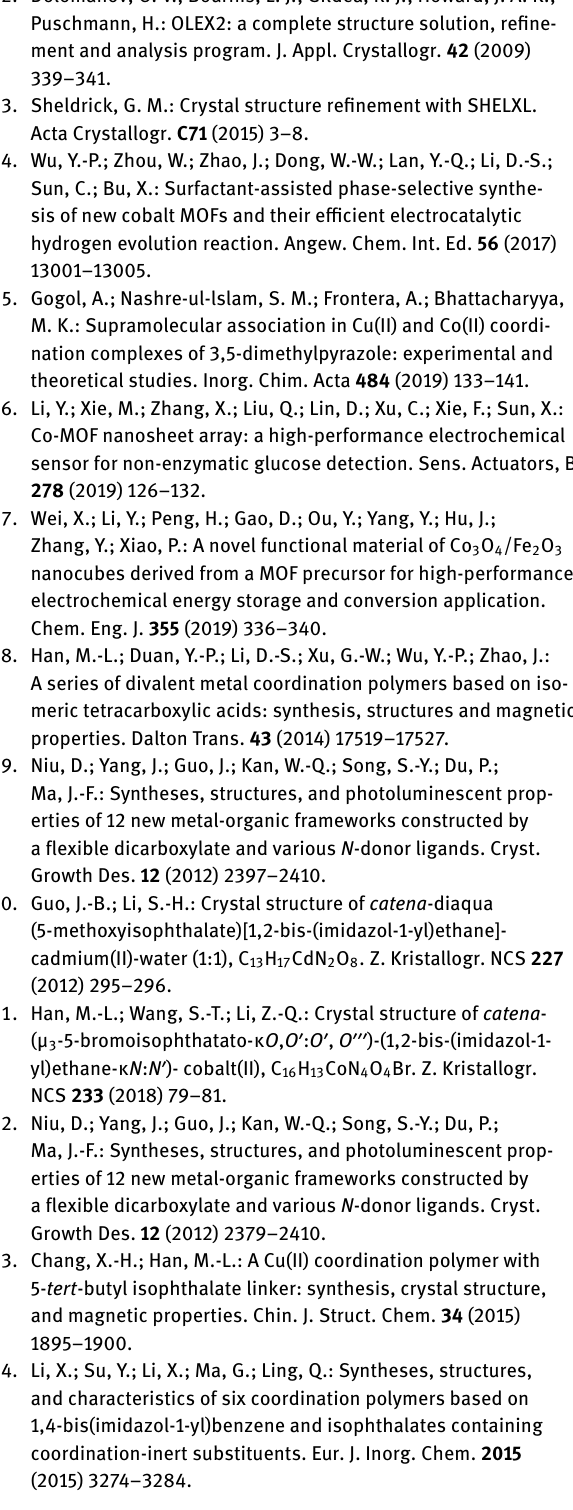
Table 2: Fractional atomic coordinates and isotropic or equivalent isotropic displacement parameters (Å 2